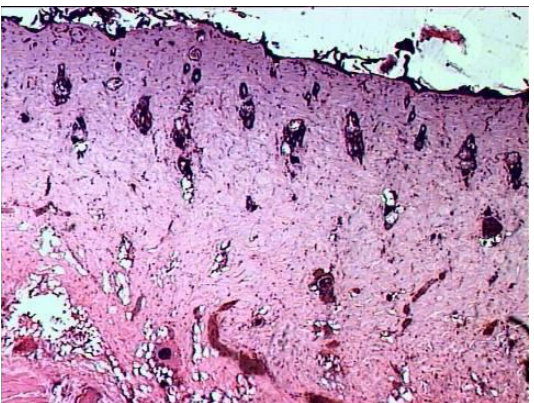
Figure 1. Histological picture of the wound on the first day after the burn (typical picture for rats of all groups). Deep burn with necrosis of the epidermis, papillary and mesh layers of the dermis, as well as necrobiosis of the muscle fibers of the skin’s own muscle. Stained with hematoxylin and eosin. magn. ×50.